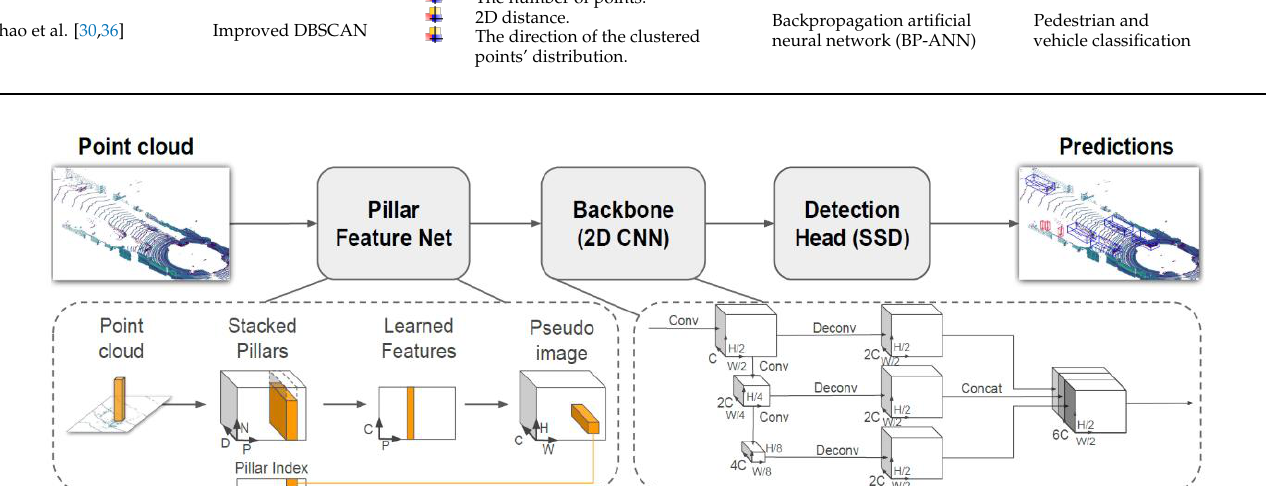
Table 3. Summary of the features used for LiDAR data classification.